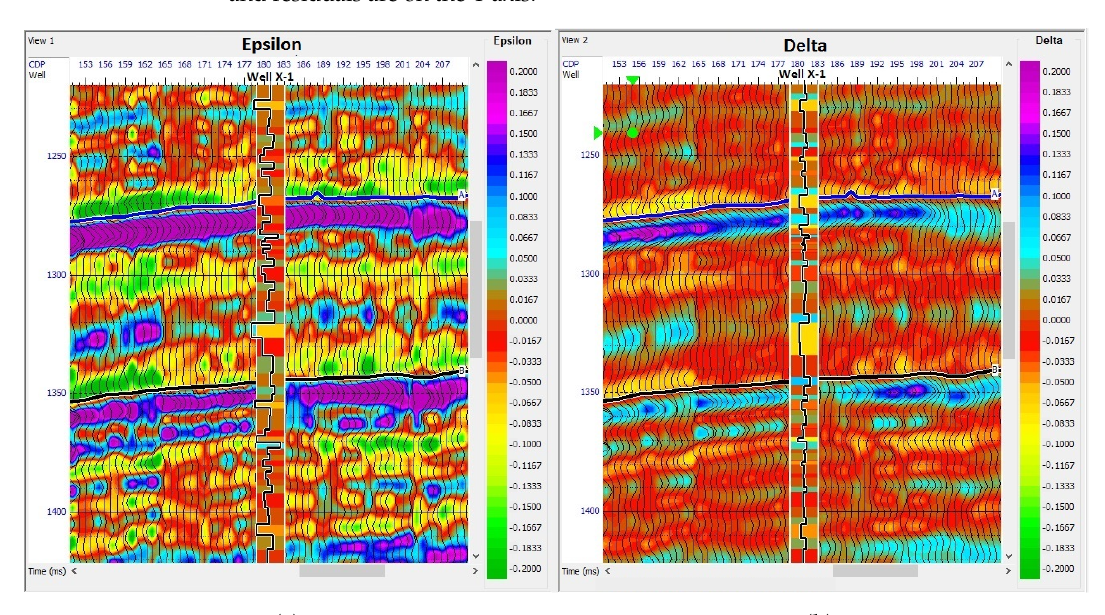
Figure 21. Cross-sections extracted from the anisotropy parameters’ volumes Epsilon ( a ) and Delta ( b ) calculated by applying the MLFN-based Z P and Z S to the impedance-domain Thomsen’s anisotropy equations. The inserted curves are the Epsilon and Delta calculated at the well ( ×